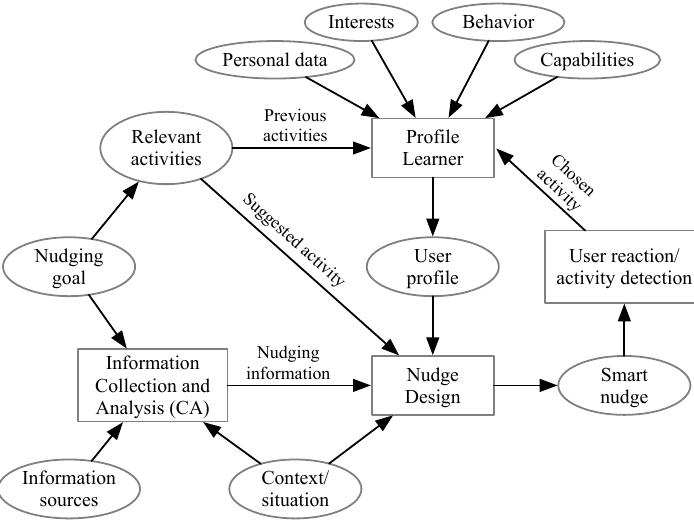
Figure 2. Architecture of a smart nudging